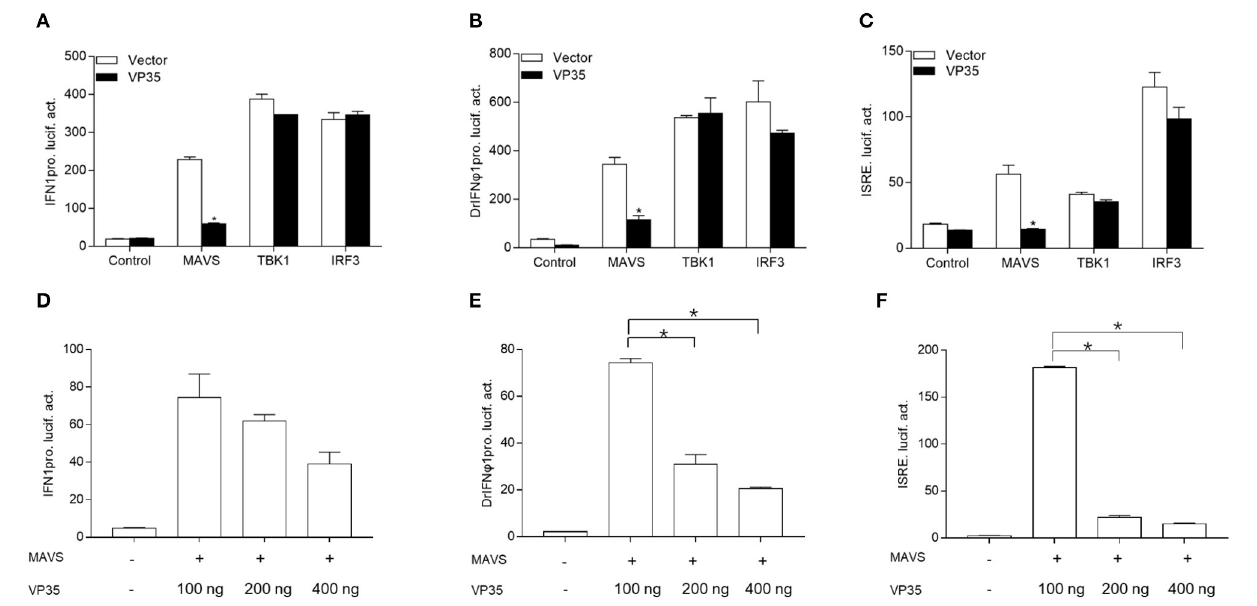
FIGURE 2 | VP35 suppresses MAVS-activated IFN induction. (A–C) GCO cells were seeded into a 24-well plate and co-transfected with 250 ng expression plasmids MAVS/TRAF family member-associated NF- κ B activator (TANK) binding kinase 1 (TBK1)/IFN regulatory factor 3 (IRF3) with 250 ng VP35-pcDNA3.1( + ) or empty vector, plus 250 ng IFN1pro-Luc (A) , DrIFN φ 1pro-Luc (B) , and ISRE-Luc (C) , and 25 ng pRL-TK. After 24h, the cells were lysed for monitoring luciferase activity. (D–F) Overexpression of VP35 inhibited the activities of IFN1pro, DrIFN φ 1pro and ISRE induced by MAVS in a dose-dependent manner. Inoculated GCO cells in a 24-well plate overnight, and co-transfected with 250 ng IFN1pro-Luc (D) , DrIFN φ 1pro-Luc (E) , and ISRE-Luc (F) , 25 ng pRL-TK, 250 ng MAVS and VP35-pcDNA3.1 ( + ) (0, 100, 200, or 400 ng). Data are expressed as mean ± SEM, n = 3. Data are expressed as mean ± SEM, n = 3. Asterisks indicate significant differences from control (* p <